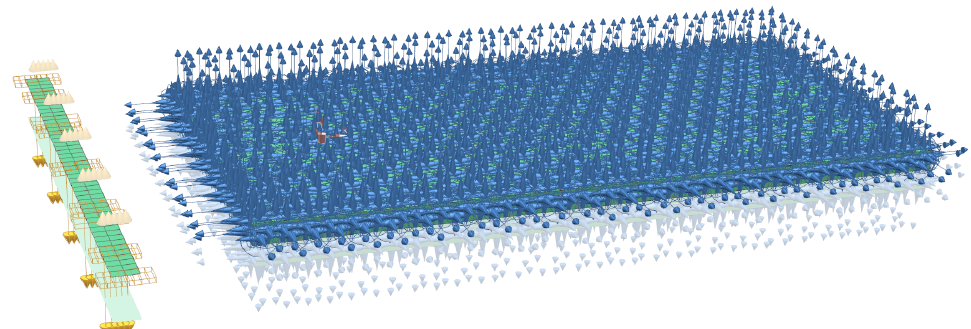
Figure 3. Simulation file representation including constraints and simulation objects. The radiation and convection constraints are only placed on the top and side faces of the flat bottom hole plate as the sample lays flat on the bottom surface. The ambient temperature is applied on every surface as an initial